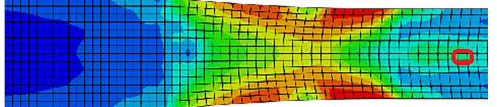
Figure 3. selected element(middle part of red circle). Figure 3. Selected element(middle part of red